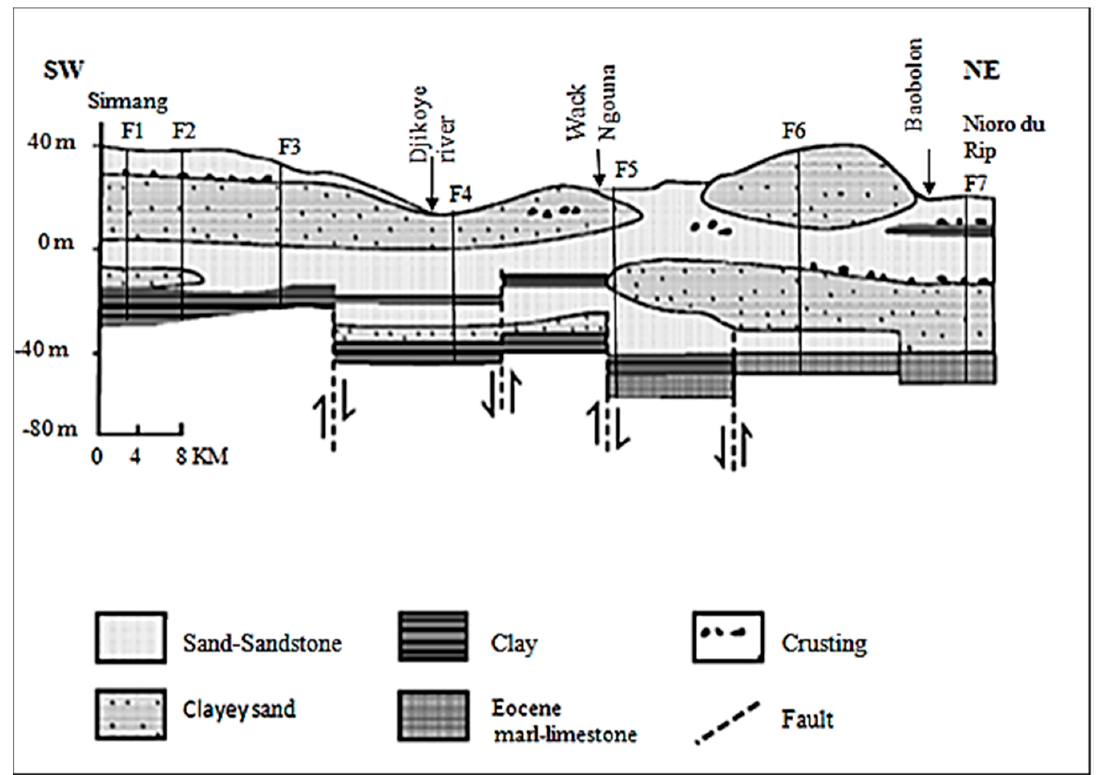
Figure 2. Geological cross section from Sirmang to Nioro du Rip [6], modified. (Location of cross section is indicated in Figure